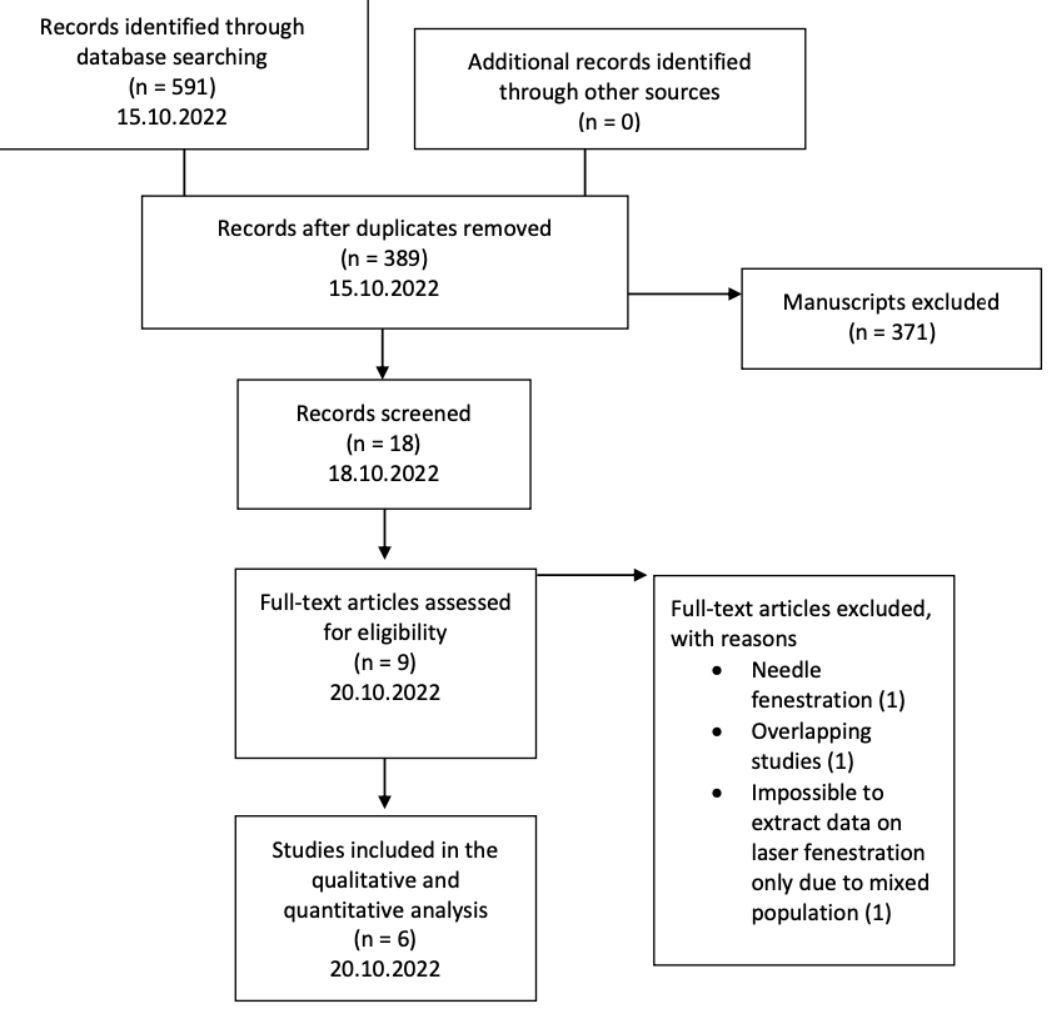
Figure 1. The flowchart of the selection process according to the PRISMA statement. Six studies were finally included in this systematic review.